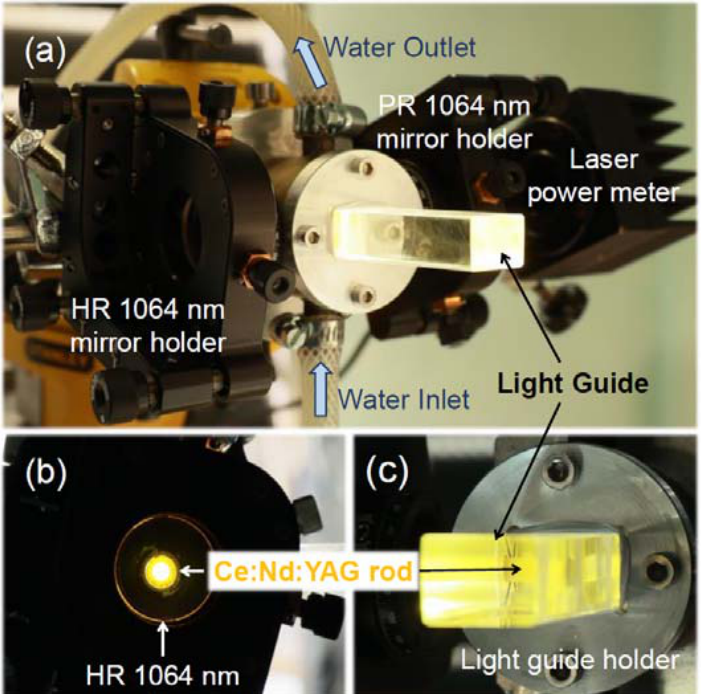
Figure 5. Photograph of ( a ) the Ce:Nd:YAG solar ‐ pumped laser head with the laser resonator and ( b , c ) the detailed view of the Ce:Nd:YAG laser medium in the experiments. HR, high reflection; PR, partial reflection.